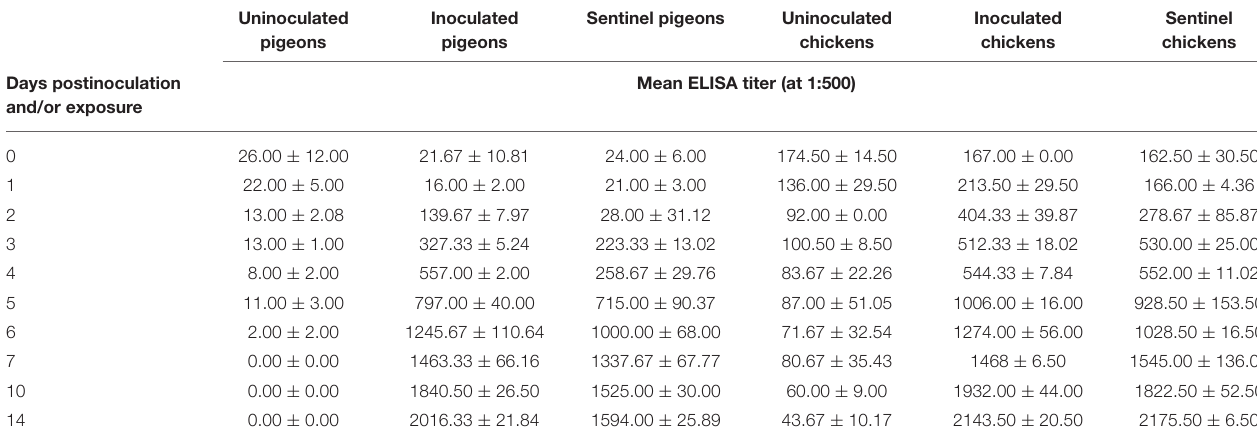
TABLE 1 | Mean IBDV ELISA titer (at 1:500) of pigeons and chickens following inoculation with and/or exposure to a very virulent infectious bursal disease virus. Uninoculated Inoculated Sentinel pigeons Uninoculated Inoculated pigeons pigeons chickens